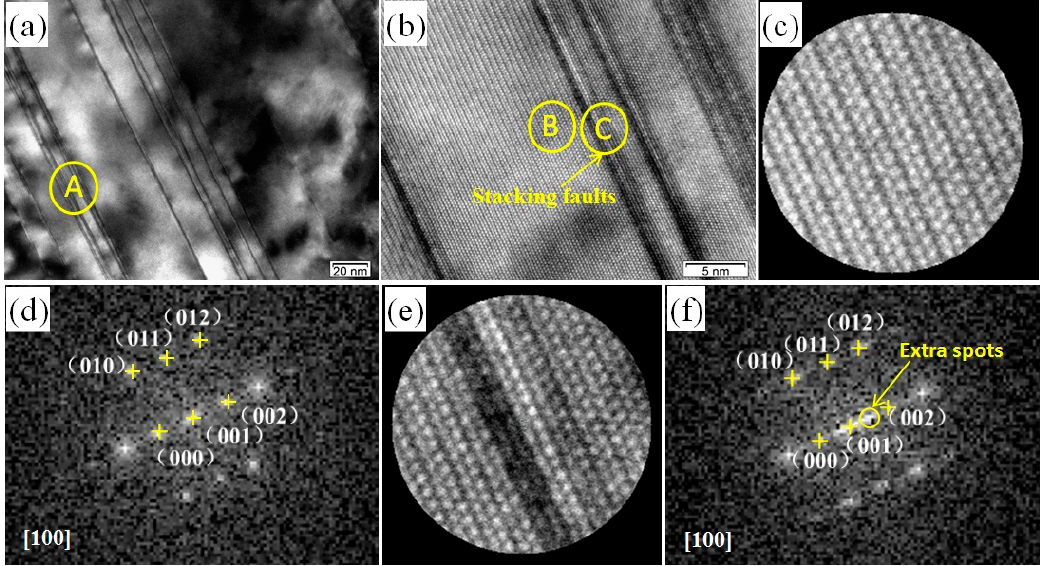
Figure 6. TEM images of 2Gd alloy: ( a ) BF TEM image; ( b ) HRTEM image; ( c ) HRTEM image of the B zone; ( d ) FFT image of ( c ); ( e ) HRTEM image of the C zone; ( f ) FFT image of ( e ).